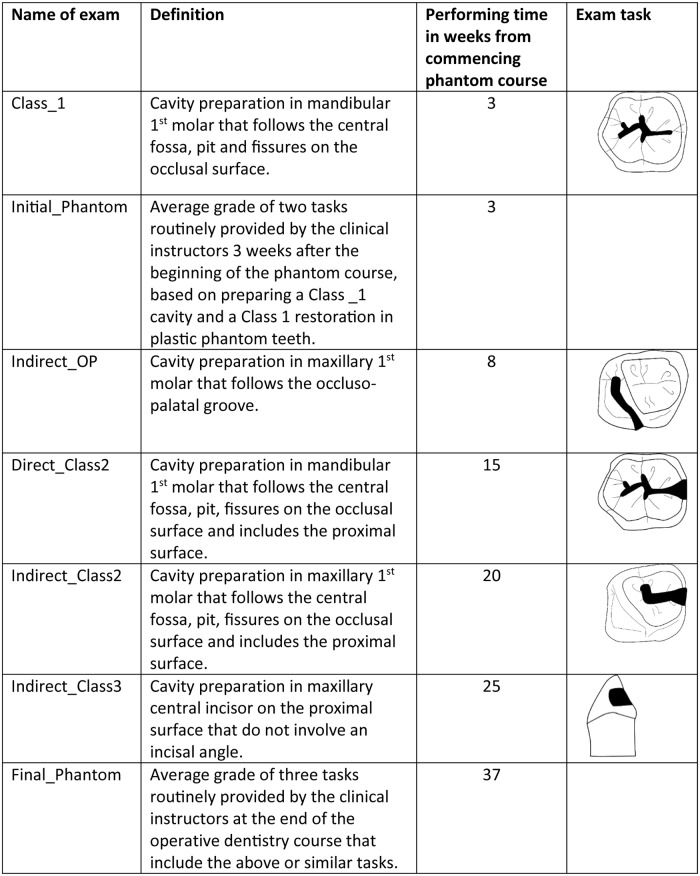
Time table and illustration of the exams’ tasks along the phantom course.